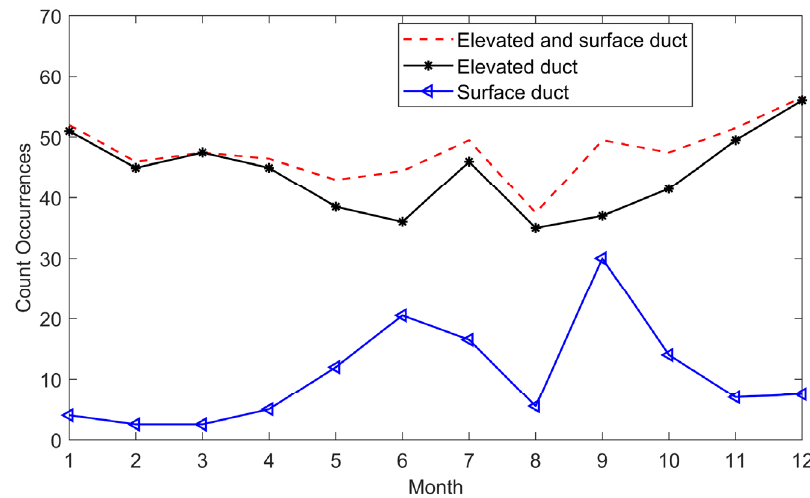
Figure 6. Monthly occurrences of surface ducts and elevated ducts.